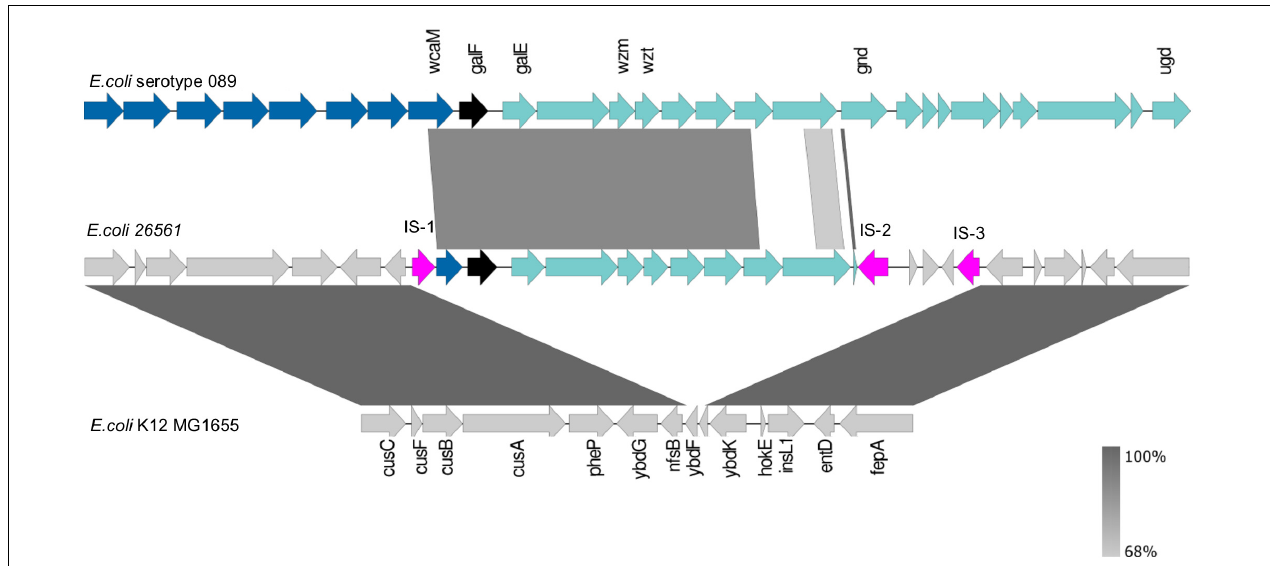
FIGURE 4 | Reference strain for E. coli serotype O89 (NCTC9089) aligned to O-antigen genes in E. coli 26561. The reference sequence for E. coli serotype O89 is shown in the upper track. The black arrow marks galF and the start of the O-antigen locus with its remaining genes to ugd shown in green. The dark blue arrows preceding galF represent the colanic acid locus. The wzm and wzt genes which are used for in silico serotyping by SerotypeFinder are labeled. Their nucleotides are 94.10% and 93.49% identical to the corresponding genes in E. coli 26561 (middle track). In E. coli 26561 we see that a partial wcaM (the final gene in the colanic acid locus) is present but interrupted by an insertion sequence at its 5 (cid:48) end (pink arrow: IS-1). The furthermost match is to the beginning of the gnd gene. The protein coding sequences for the two genes preceding gnd , a methyl transferase and glycosyl transferase, are 47% and 42% identical, respectively, but are a 100% match to other proteins with the same function in the NCBI database. The genes which flank the insertion sequences marked IS-1 and IS-3 in E. coli 26561 are nfsB and ybdK . The bottom sequence illustrates that these genes are usually separated by two small hypothetical genes, ybdF and ybdJ , in E. coli K12_MG1655 ( ybdJ is not labeled in the